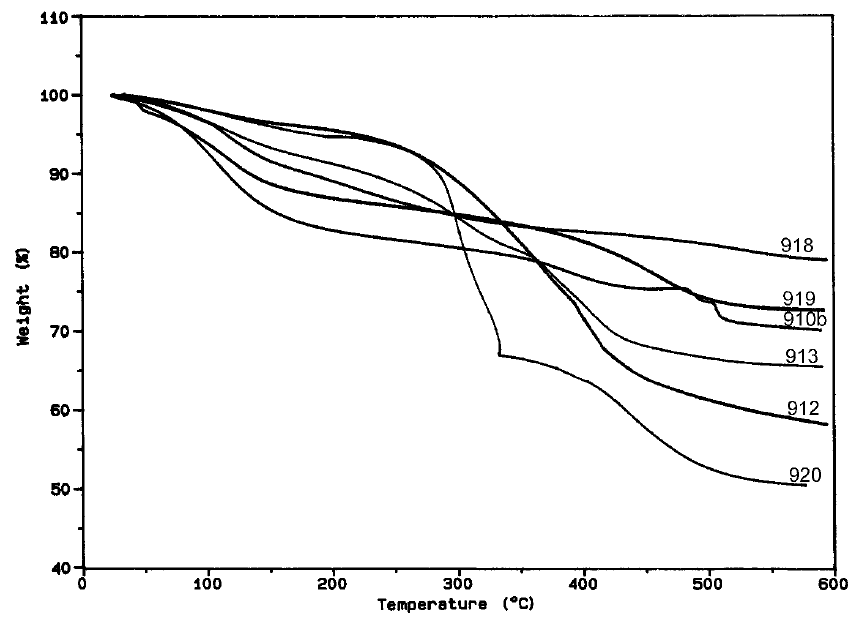
Fig. 5 TGA diagram of sol-gel reaction products without polymerization (s.910: TIP; s.912: TIP+MPTS; s.913: TIP+MPTS; s.918: TIP+VTES; s.919: TIP+MeTES; s.920: